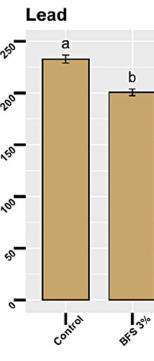
Figure 6. PTE content in roots and aerial parts in plants with Blast Furnace Slag (BFS).